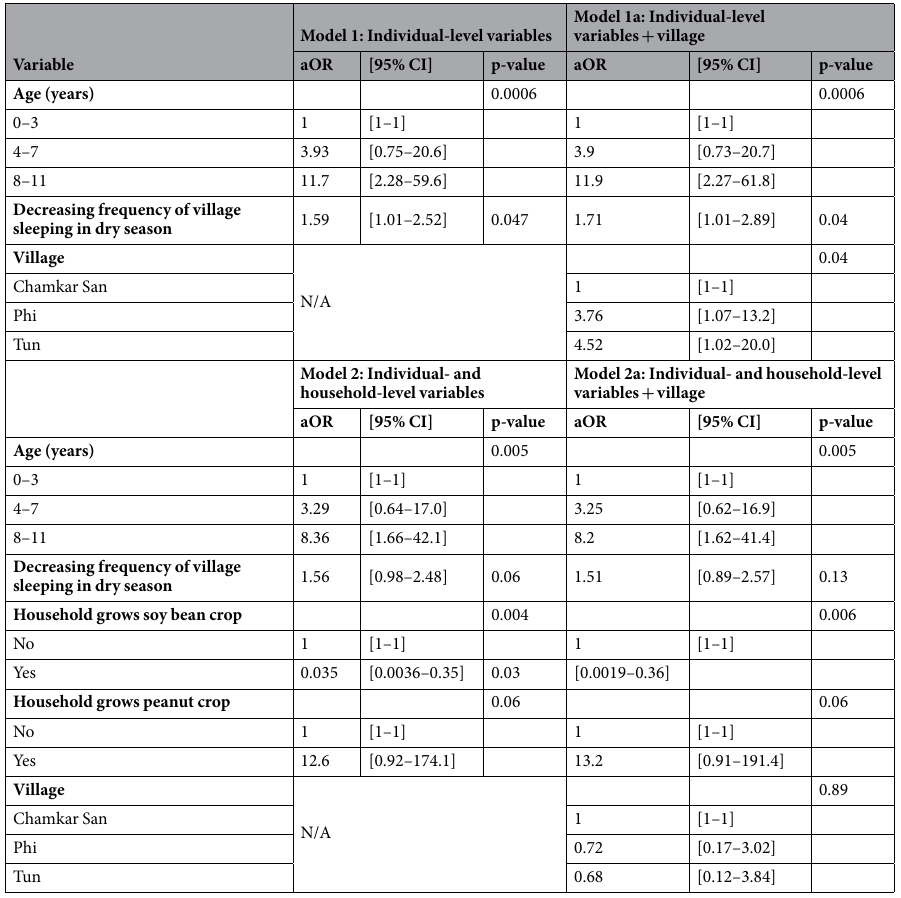
Table 7. Individual and household-level risk factors for Plasmodium infection